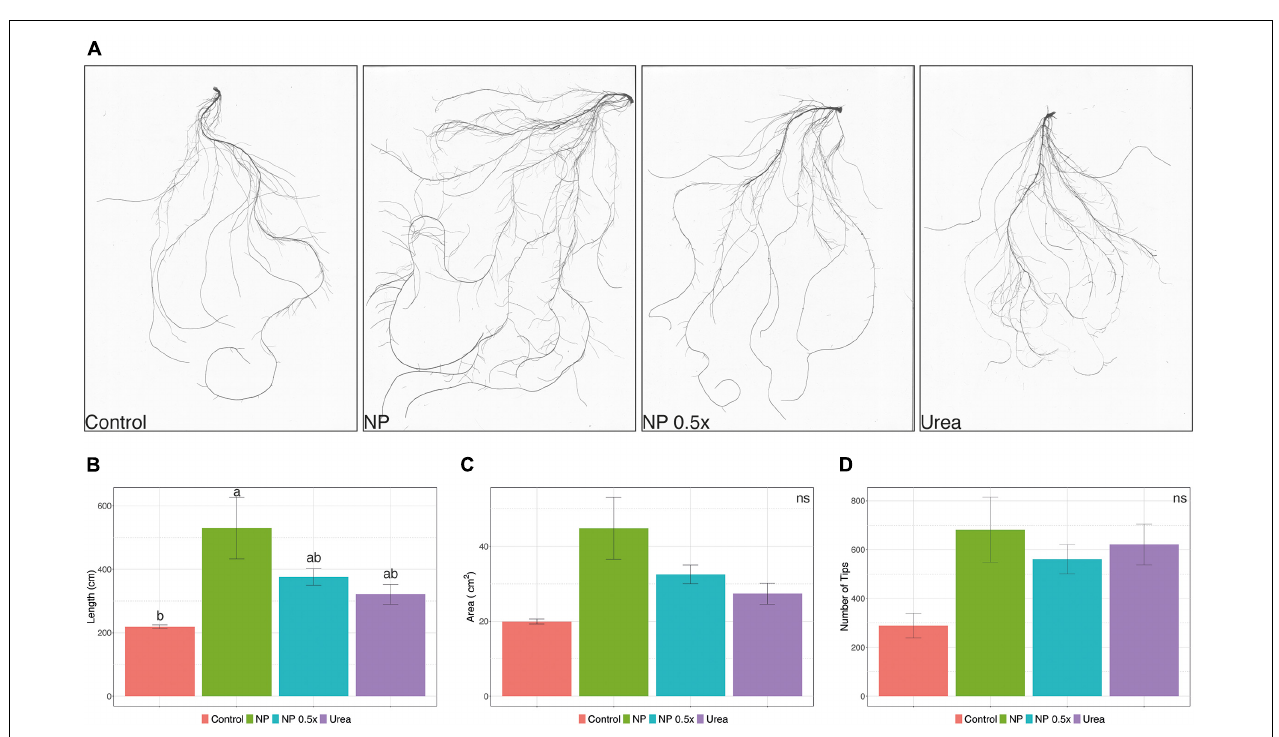
FIGURE 3 | Effects of different treatments on root architecture. (A) Representative pictures of cucumber root systems, (B) total root length, (C) total root surface area, and (D) root tips of cucumber plants either not treated (control) or supplied with 1 mM urea, NP, or NP.5 × . The assessments have been carried out at harvest (i.e., 7 days after the treatments as depicted in Supplementary Figure 2C ) on at least six independent biological replicates. Data are reported as means ± SE. Different letters indicate significantly different values as determined by one-way ANOVA with Tukey post hoc tests ( P <